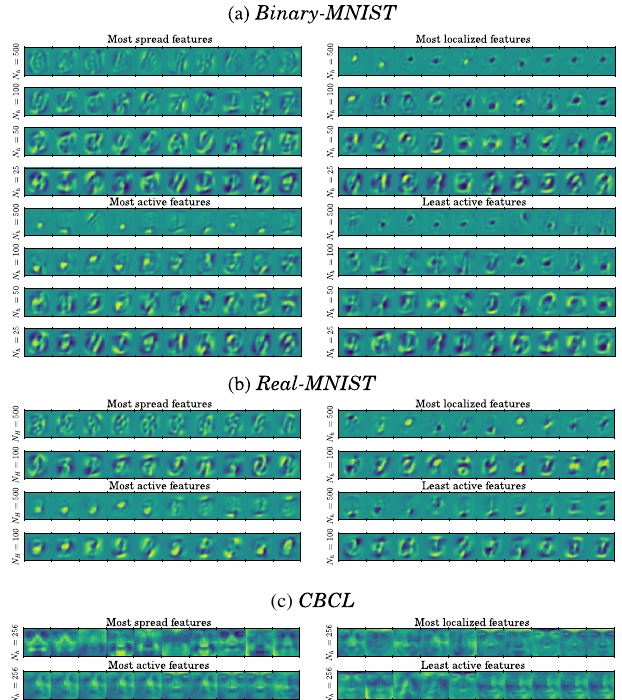
FIG. 4. Subsets of the final receptive fields, i.e., the columns of W , obtained by TAP training of GRBM models with varying numbers of hidden units, N h . For the receptive fields, dark blue and yellow are mapped to − 1 and þ 1 , respectively, and green indicates a value of 0. Receptive fields are ranked according to two criteria: first, spread, and conversely localization, as mea- sured by the l p -norm of the receptive field, for p ¼ 0 . 1 , and second, by activation level, as measured by the mean activation of each receptive field ’ s corresponding hidden unit averaged across the training data